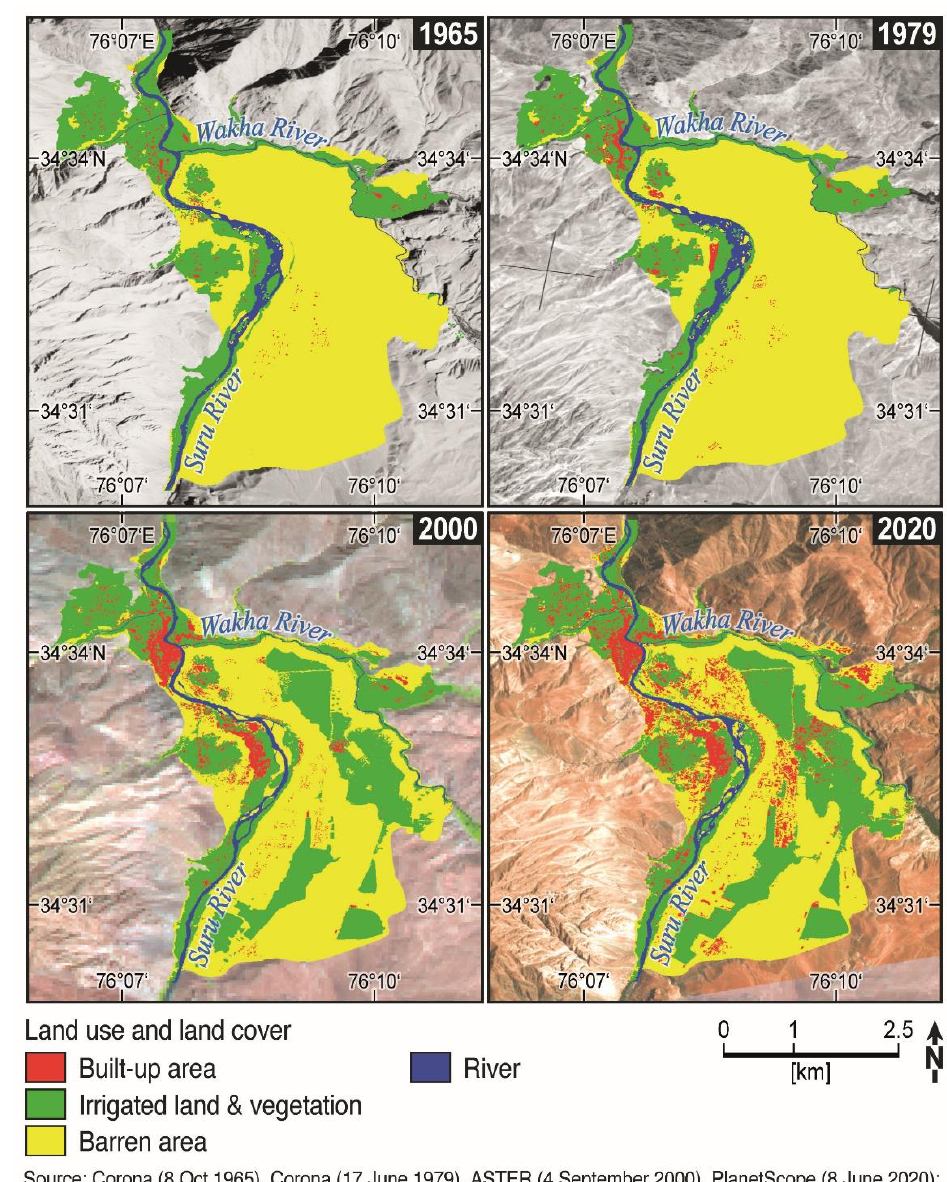
Figure 4. Land use and land cover (LULC) maps of Kargil town from 1965 to 2020. Table 4. Percentage and square kilometre of land use and land cover (LULC) in 1965, 1979, 2000 and 2020 and their changes.